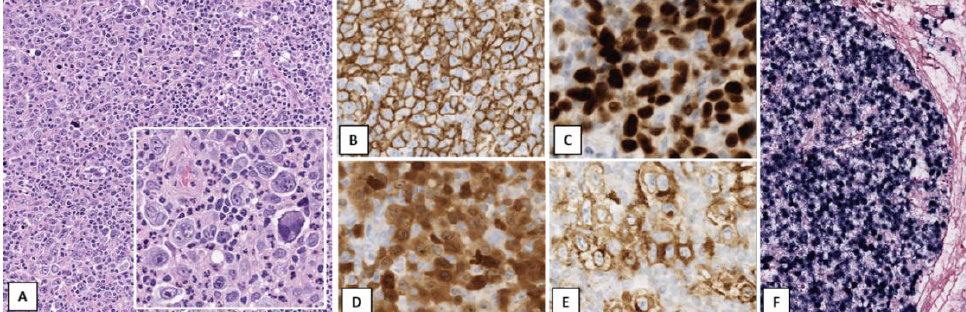
Figure 5. EBV+ Diffuse large B cell lymphoma with Hodgkin-like morphological features. Effaced supraclavicular lymph node in an 84-year-old male with large pleomorphic cells with HRS features ( A ). Diffuse positivity for CD20 ( B ), Oct-2 ( C ), BOB.1 ( D ) and CD30 ( E ). EBERs confirm EBV positivity ( F ). [Original magnification: A: ×200, A inset: ×400; B: 300×; C – E: ×400; F: ×100].